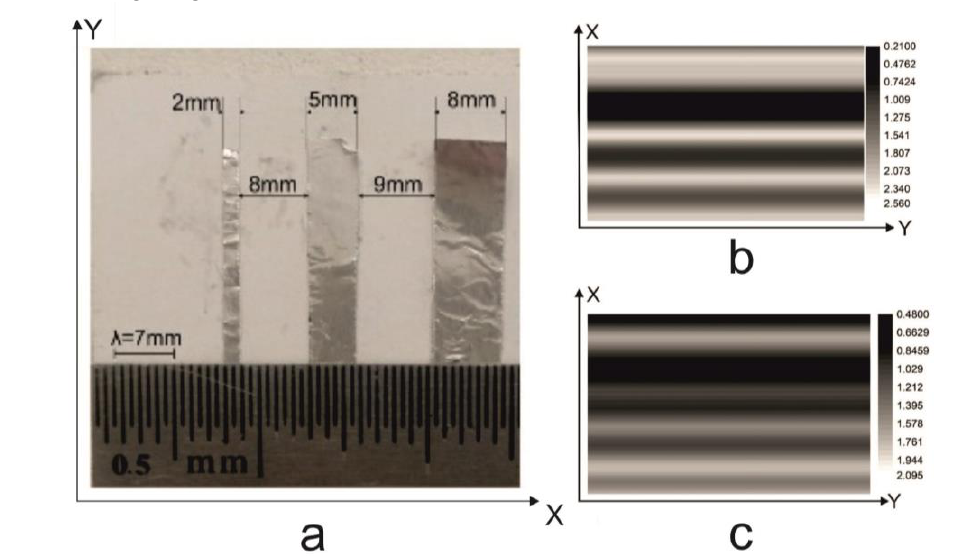
Fig. 4. Image of a test sample with metal stripes (a); The result of visualization of the intensity distribution matrix of transmitted electromagnetic radiation in a two-dimensional plane with (b) and without using a focusing element (c). Shades of gray characterize the signal level from the detector in absolute